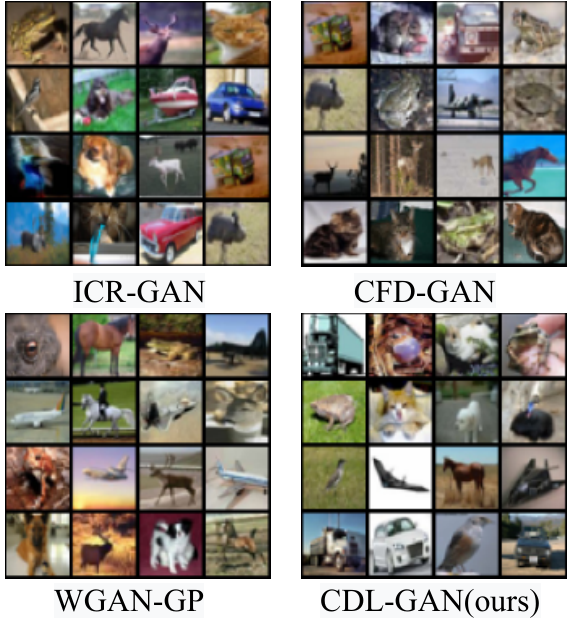
Figure 6. Image samples from different models on CIFAR-10